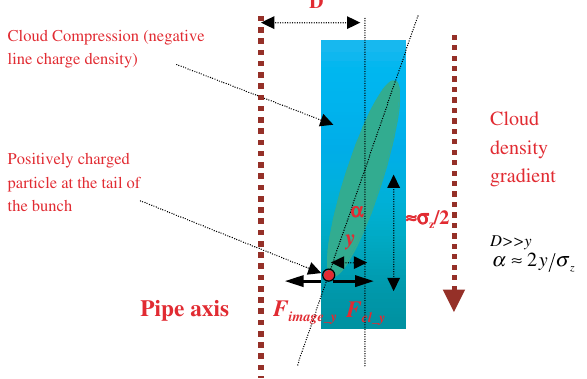
FIG. 5. (Color) Electrons attracted by a vertically displaced beam are modeled as a line density whose images with respect to the perfectly conducting wall act back on the beam. The green box is the conducting cavity.